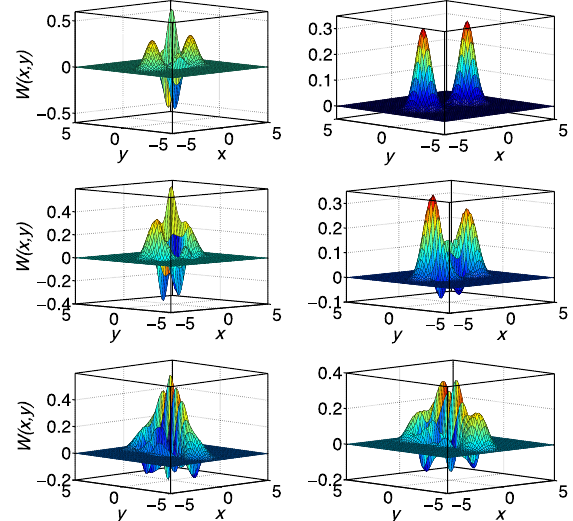
FIG. 3. Wigner function W ð x; y Þ of the field state after interaction time g eff t ¼ (cid:2) , calculated ab initio withthe parameters of Fig. 1. Top-left panel: (cid:1) 2 ¼ 0 , ! eff ¼ g eff , qubit postselected in the ground state. Top-right panel: (cid:1) 2 ¼ 0 , ! eff ¼ g eff , qubit traced out. Center-left panel: (cid:1) 2 ¼ 2 (cid:2) (cid:6) 10 MHz , ! eff ¼ g eff , qubit postselected in the ground state. Center-right panel: (cid:1) 2 ¼ 2 (cid:2) (cid:6) 10 MHz , ! eff ¼ g eff , qubit traced out. postselected in the ground state. Bottom-right panel: (cid:1) 2 ¼ 0 , qubit traced 2 (cid:2) (cid:6) 10 MHz , ! eff ¼